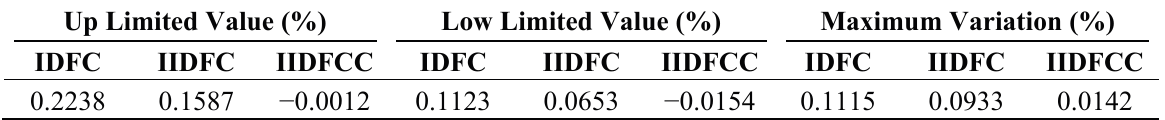
Figure 5. ( a ) The R = 1 Ω and R R 0 where M = N = 8, R